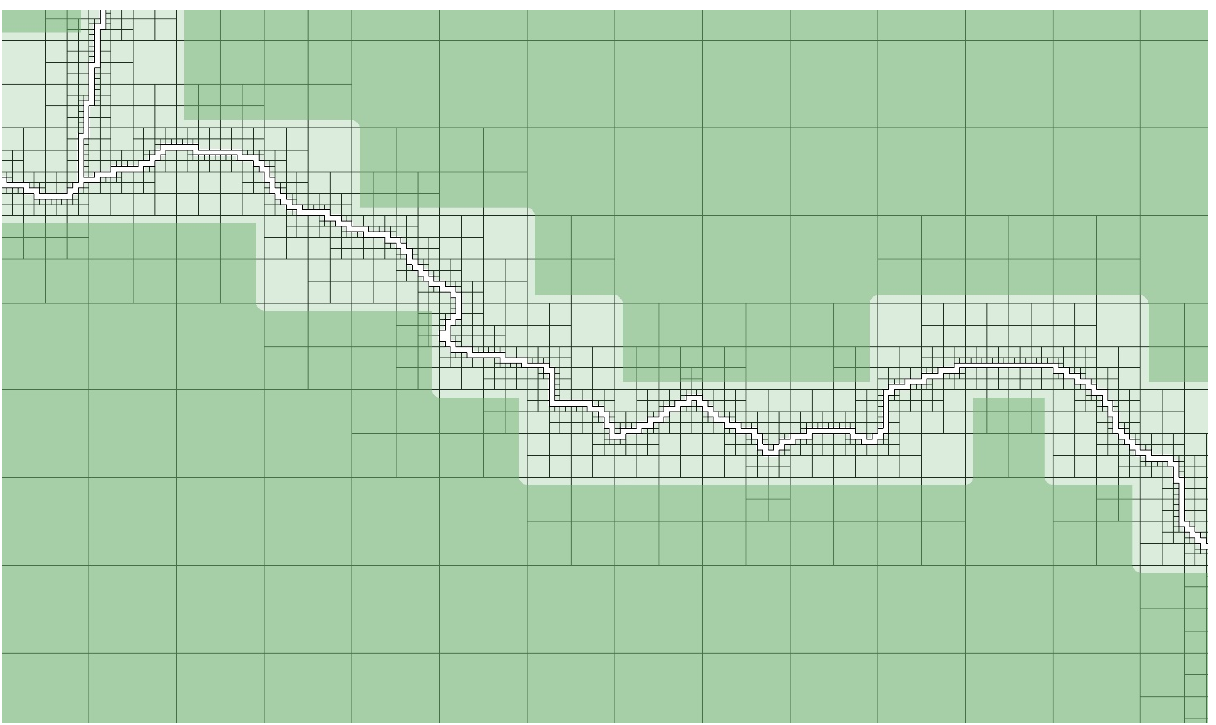
Figure 7. Drainage area in the two conceptualizations for a part of Holtum stream. Blank cells represent the area occupied by stream cells in the IRREG model. The largest cell is 100 × 100 m. The dark green area delineates the drain polygon of the REG model. The light green area delineates the additional drainage area in the IRREG model and the area occupied by stream cells in the REG model.